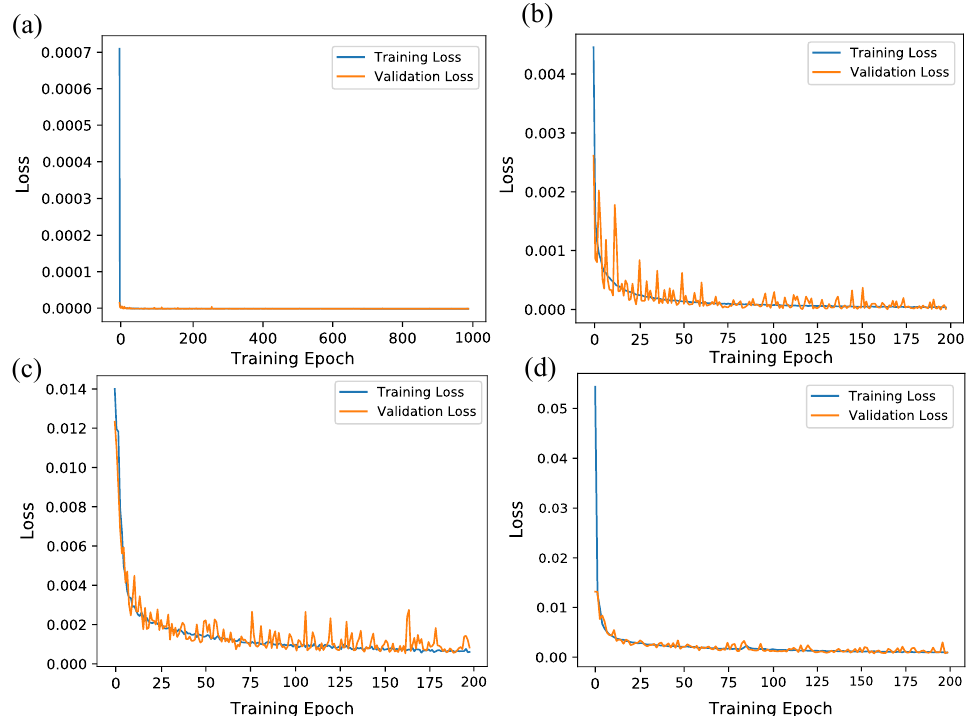
Figure 6. Training and validation loss for the deep long short term memory (LSTM) neural network with multi-timestep predictive horizon. ( a ) 1 timestep predictive horizon. ( b ) 50 timesteps predictive horizon. ( c ) 100 timesteps predictive horizon. ( d ) 200 timesteps predictive